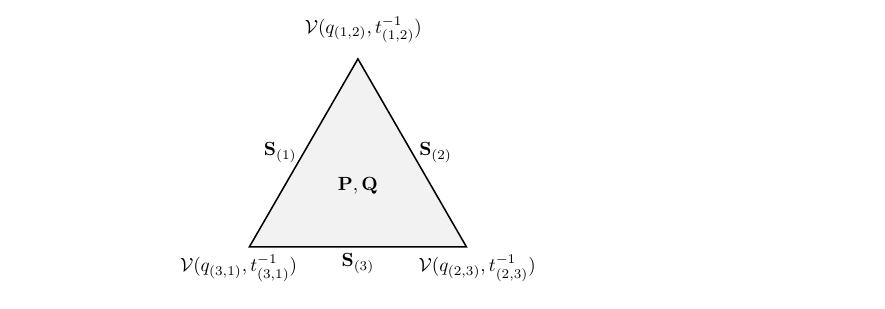
Figure 3. A pictorial representation of the gluing of three q -Virasoro algebras into the modular